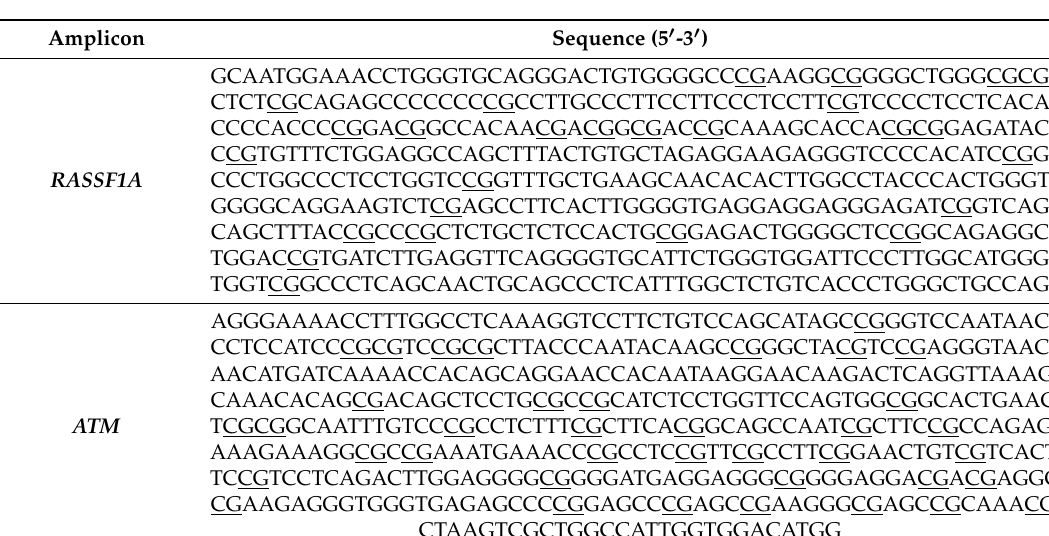
Table 7. Sequences of the target